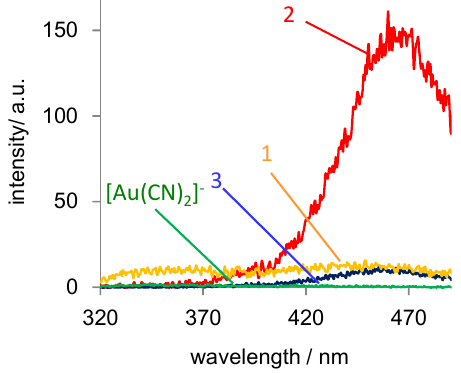
] − , 2 /[Au(CN) ] − and 3 /[Au(CN) 2 2 ] = 1:1). 2